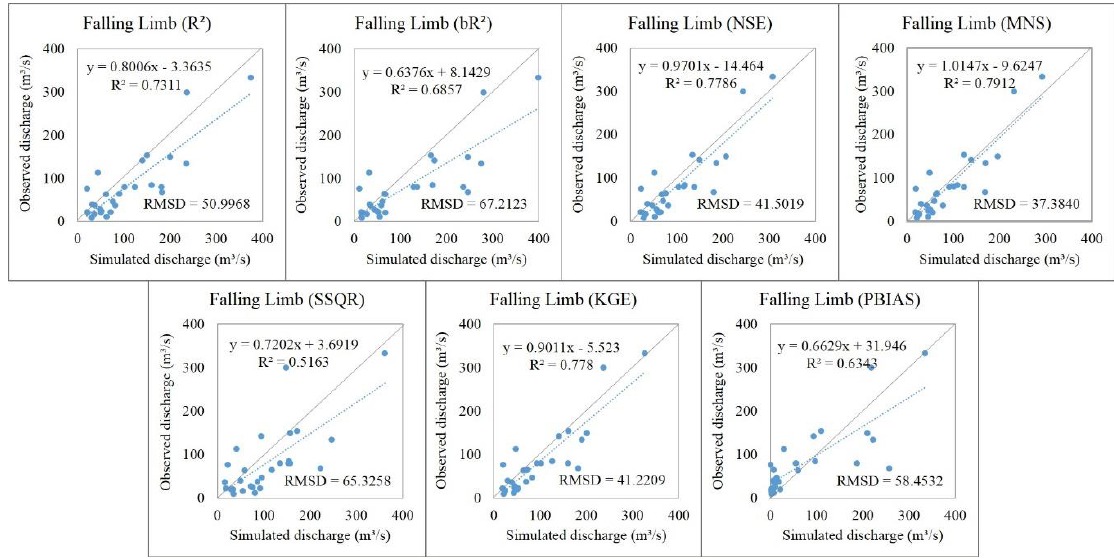
Figure 11. Scatter plots of the simulated versus observed falling limbs for different objective functions.